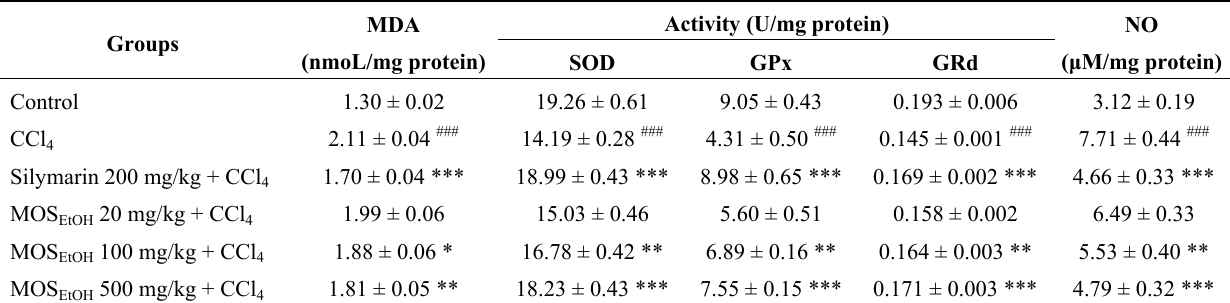
Table 3. Effect of MOS enzymes in rats treated with CCl